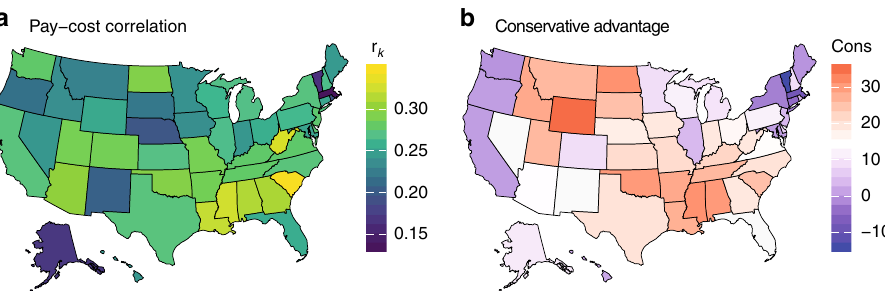
Fig. 2 Geographical distribution of the payments – costs association and conservative advantage. a Partial Spearman correlation ( r k ) between industry payments to healthcare providers and their total Medicare medical (non-drug) costs, controlling for the number of bene fi ciaries per provider, in each state. b State-wide conservative advantage as reported by the 2016 Gallup poll on conservative ideology 35 . Among several key political, economic and social factors, conservative advantage was the most strongly correlated with r k